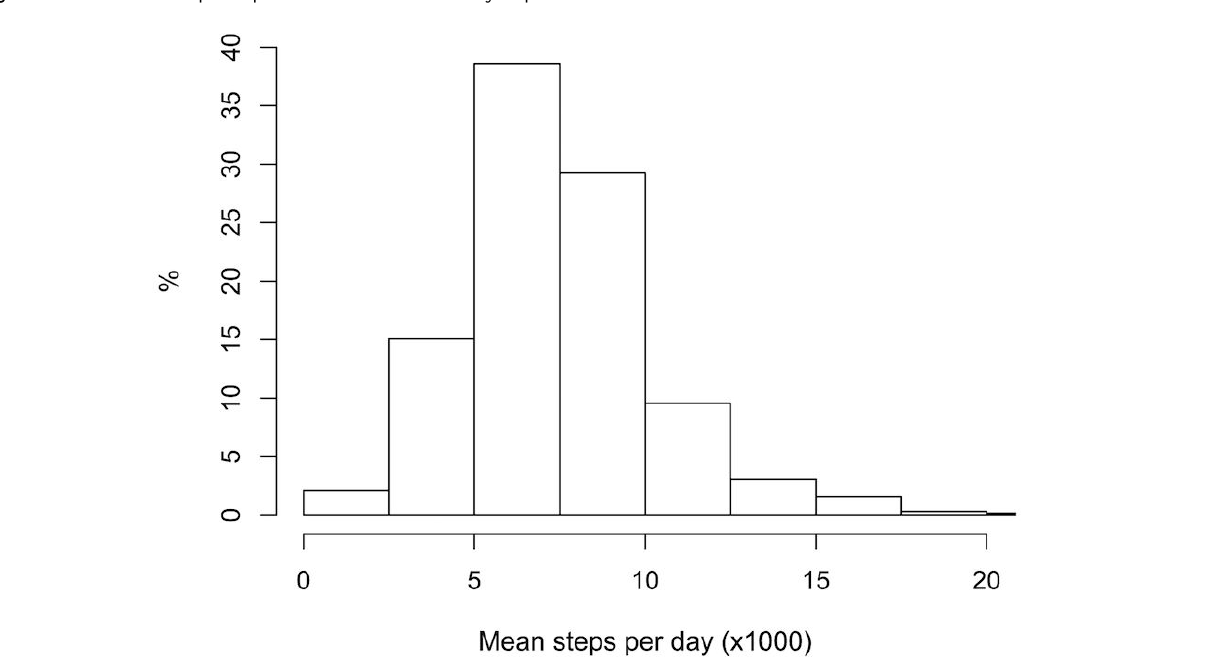
Figure 3. Distribution of participants’mean number of daily